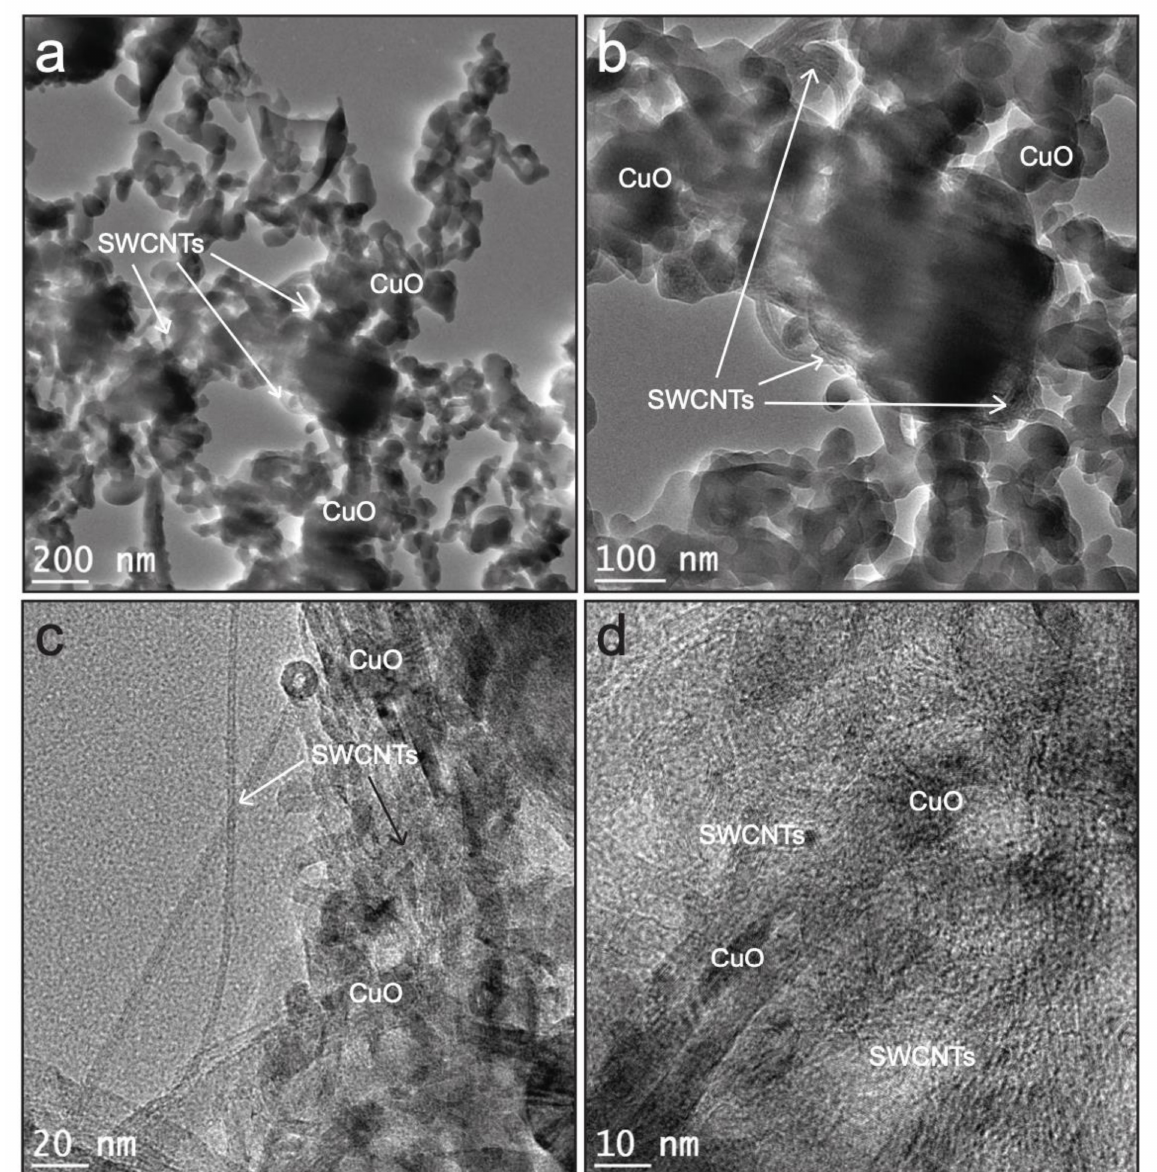
Figure 2. FE-EF-TEM images of CuOSC-3 nanocomposite displaying the attachment of CuO nanocrystals on the walls of SWCNTs via heterojunction formation: ( a – b ) interconnected networks of CuO and SWCNTs, ( c ) distribution of CuO and SWCNTs in the nanocomposite, and ( d ) lattice fringes of CuO and SWCNTs under high